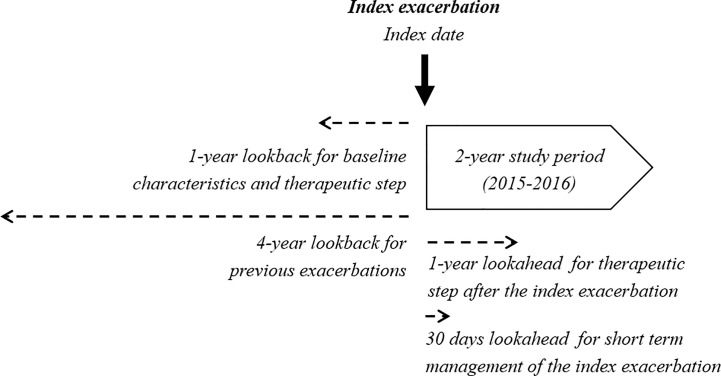
Time frames employed for assessment.